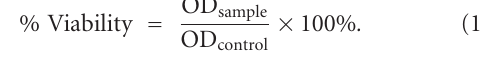
MCF10A (human nontumorigenic breast cell line) (ATCC) and PBMC (human peripheral blood mononuclear